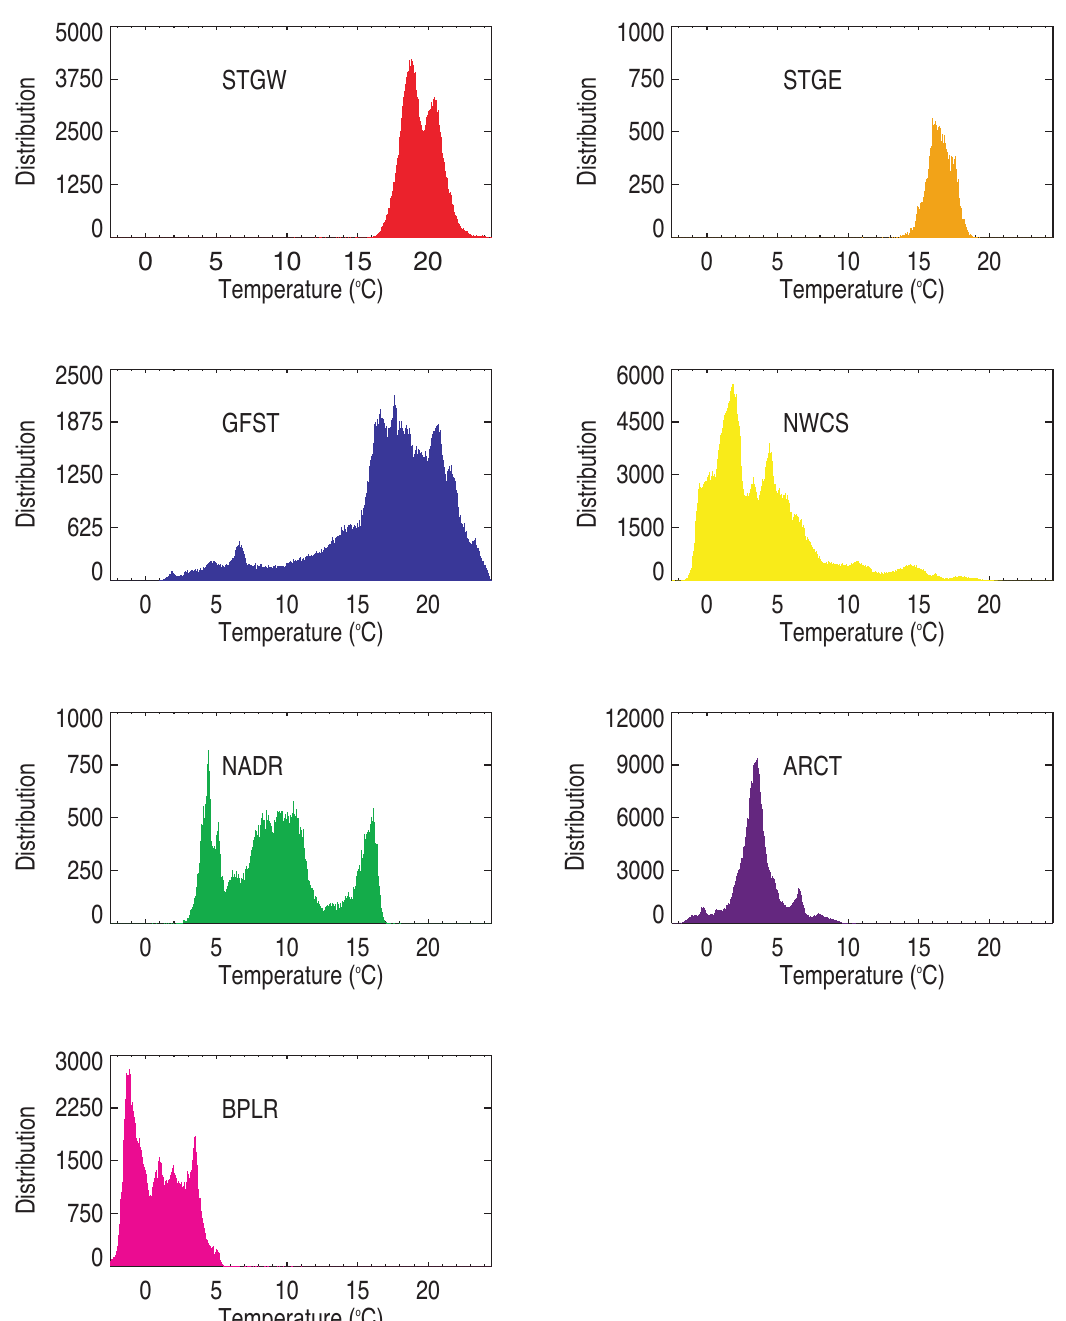
Fig. 7. – Frequency distribution of sea surface temperatures for the spring season extracted from the composite image for the provinces defined by Sathyendranath et al .